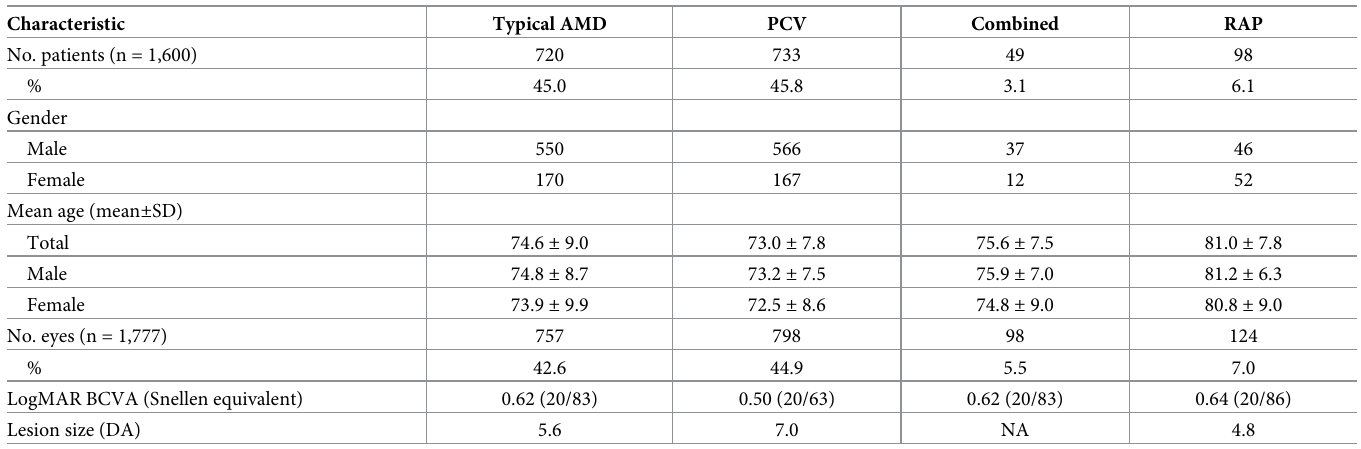
Table 1. Characteristics of neovascular AMD in this study.